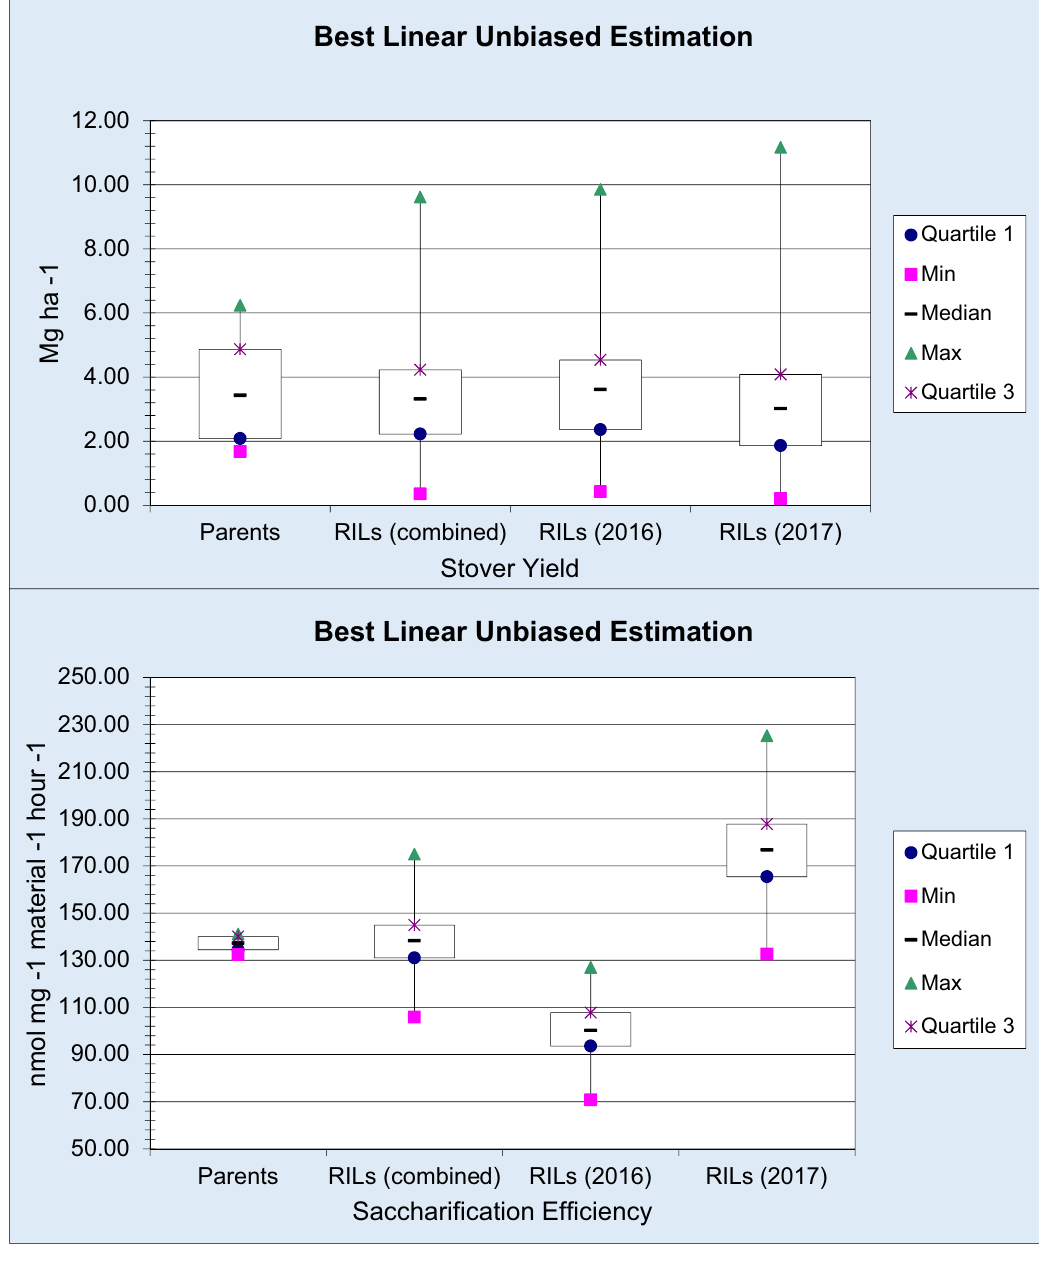
Figure 1. Saccharification efficiency and stover yield values in RILs (combined and by years) and parent lines of the MAGIC population (Best Linear Unbiased